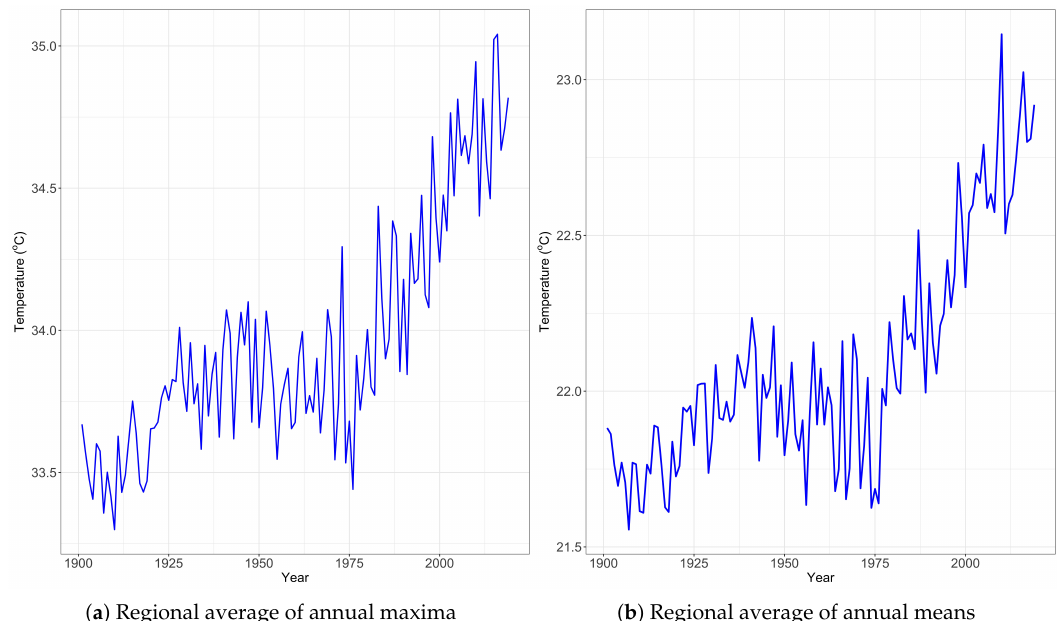
Figure 3. Time series of the regional averages of annual maximum and annual mean temperatures for the African region over the period of 1901 to 2019: ( a ) Annual maxima, ( b ) Annual means.